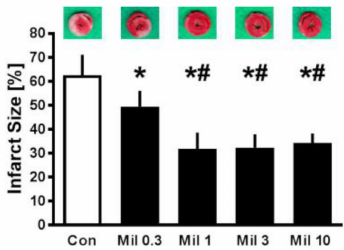
Figure 3. Infarct size measurement. The infarct size of controls (Con) and di ff erent concentrations of milrinone (Mil) preconditioning. For each group, an exemplary heart slice is shown. Data are mean ± SD. * p < 0.05 vs. Con, # p < 0.05 vs. Mil.